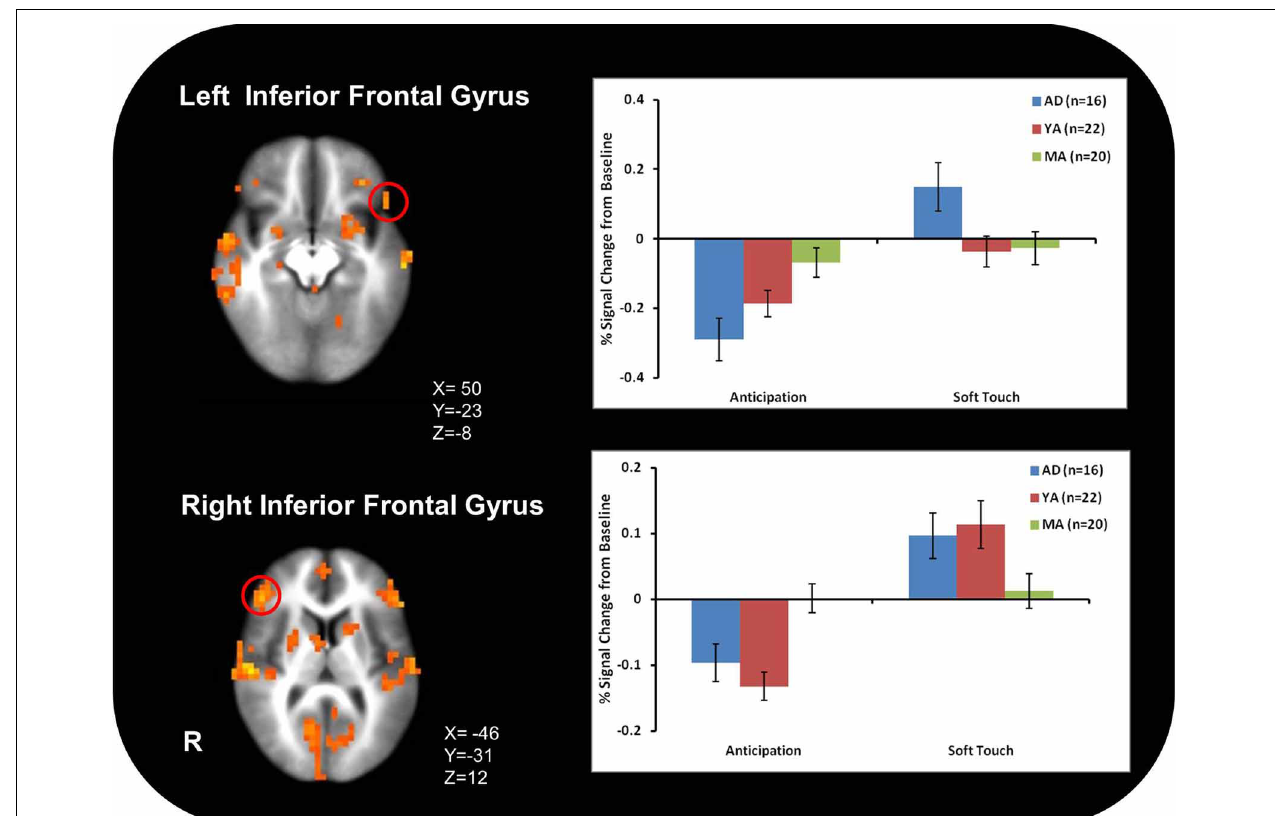
FIGURE 4 | Adolescents (AD) showed greater activation than mature adults (MA) in bilateral inferior frontal gyrus (IFG). However, young adults (YA) showed deactivation in left IFG and activation comparable to adolescents (AD) in right